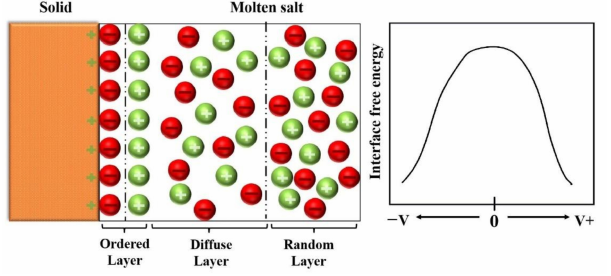
Figure 6. Schematic diagram of the arrangement of positive and negative ions and the change of interfacial tension generated by the electric field acting on the solid-liquid